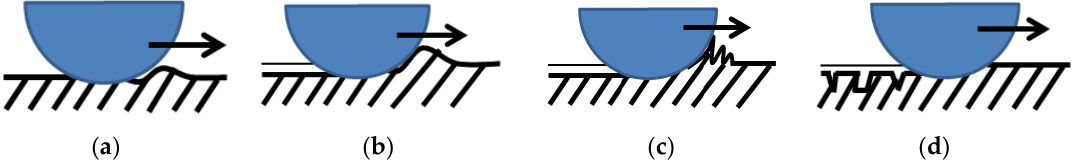
Figure 1. Wear micro-mechanisms to produce wear debris: ( a ) micro deformation; ( b ) micro ploughing; ( c ) micro cutting; ( d ) micro cracking [1].